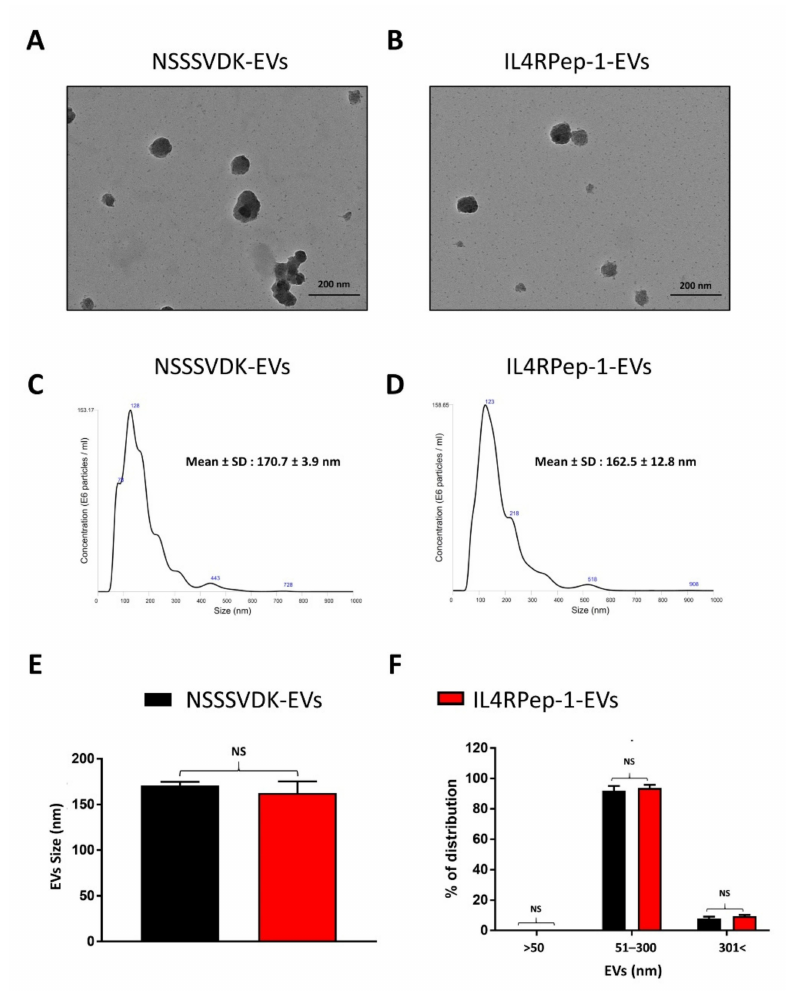
Figure 3. Peptide labeling maintains the morphology, size, and distribution of extracellular vesicles (EVs). ( A , B ) Morphology of NSSSVDK-EVs and IL4RPep-1-EVs confirmed by transmission electron microscopy (TEM; scale bar: 200 nm). ( C – E ) Size of NSSSVDK-EVs and IL4RPep-1-EVs determined by nanoparticle tracking analysis (NTA) (Diameters: NSSSVDK-EVs, 170.7 ± 3.9 nm; IL4RPep-1-EVs, 162.5 ± 12.8 nm). ( F ) Percentage distribution of NSSSVDK-EVs and IL4RPep-1-EVs represented on bar graph (approximately 95% of EVs ranged in size between 50 and 300 nm). Data are repre- sented as means ± standard deviations. Statistical differences between groups were analyzed using Student’s t